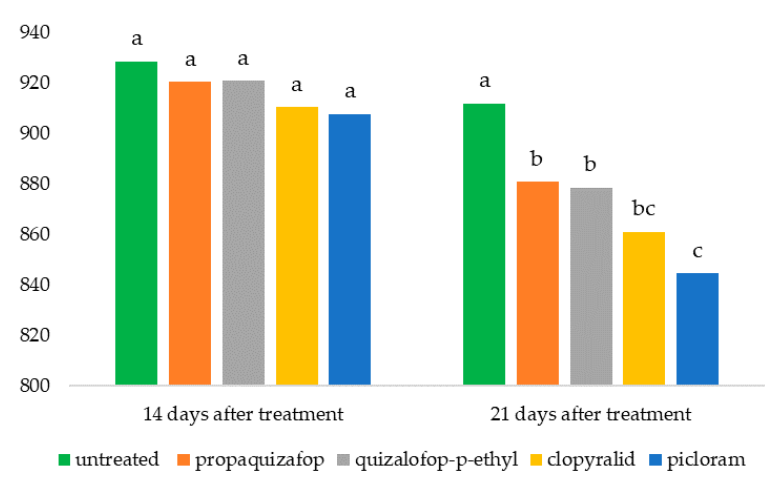
Figure 2. The effect of herbicides on Fv—variable fluorescence (non-nominated units). Different letters ( a-c ) indicate statistically different mean LSD ( p < 0.05) 14 DAA = 19.52; LSD ( p < 0.05) 21 DAA = 25.91; DAA - days after herbicides application.